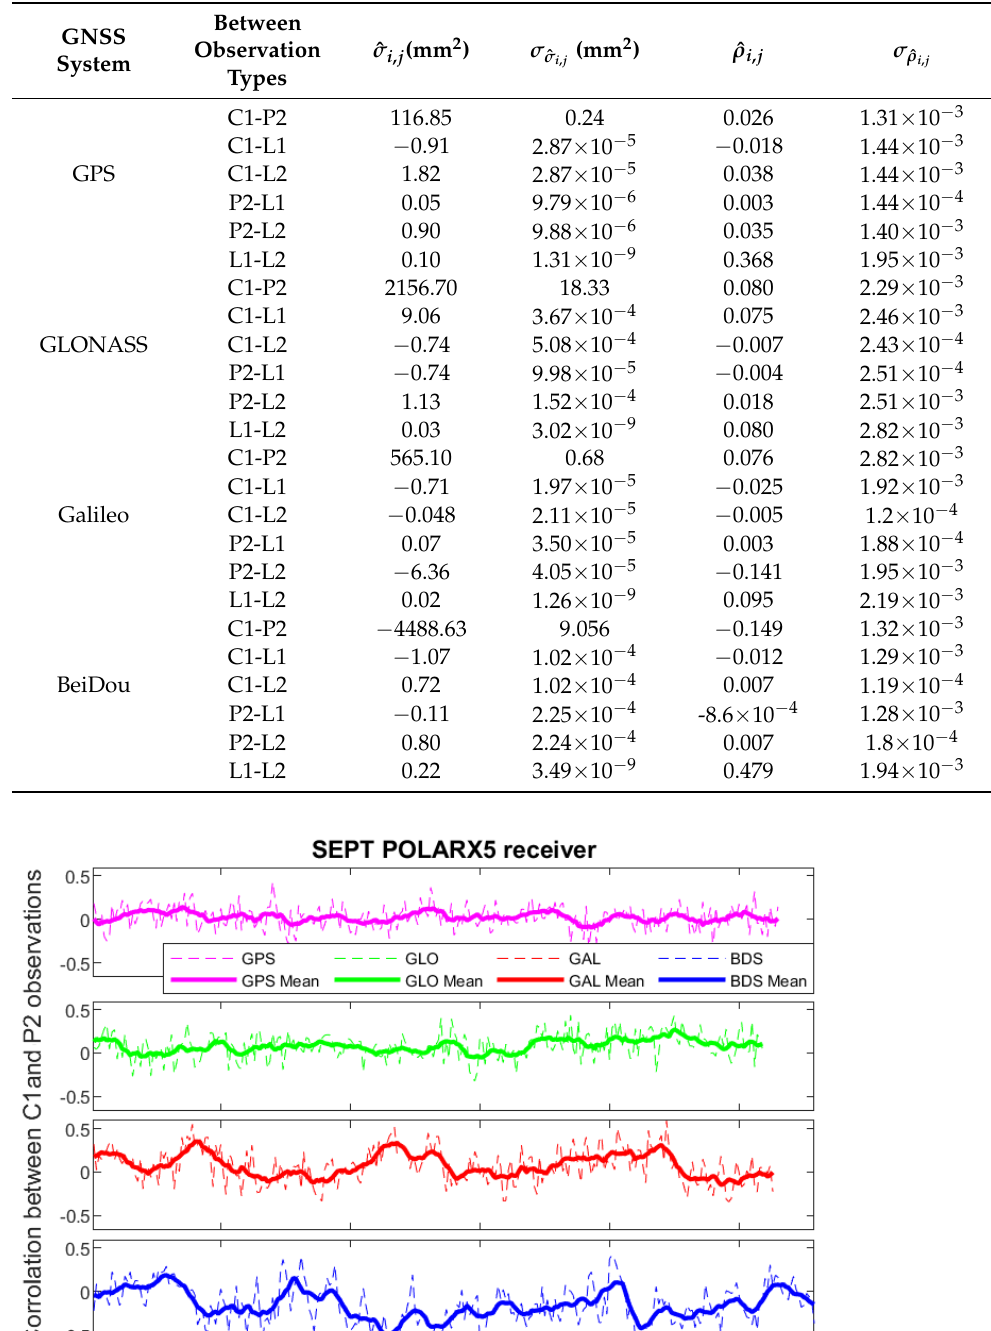
Table 6. Covariances and correlation coefficient and their precision between the observation types for each system for SEPT POLARX5 receiver over a very short baseline.